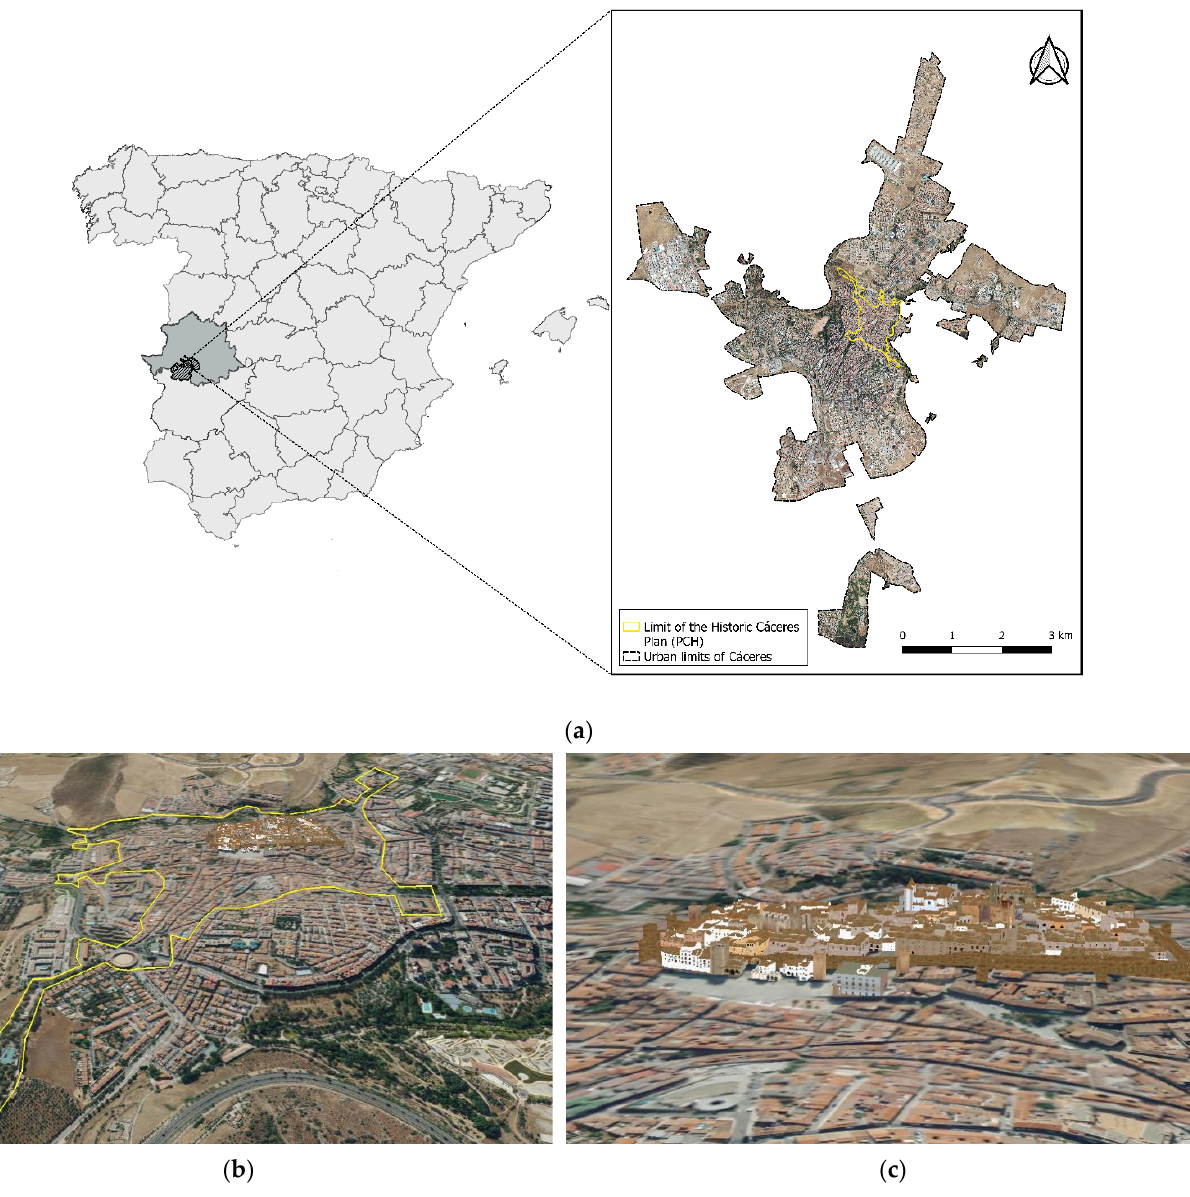
Figure 1. ( a ) Study area location; ( b ) PCH panoramic image; ( c ) Historical centre of Cáceres, 3D image [34].